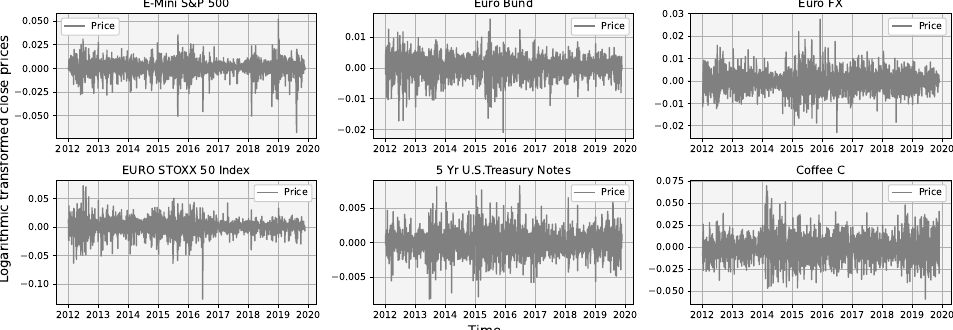
Figure 5. Selected futures prices after logarithmic transformation during an 8 year